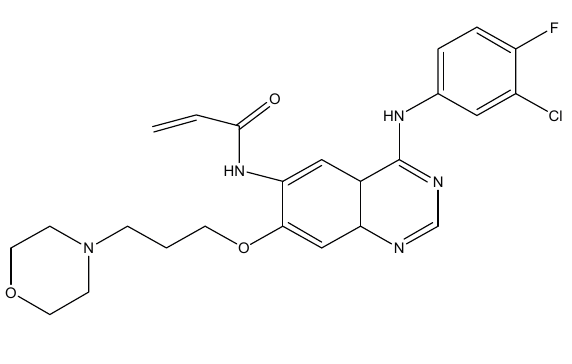
Figure 11. Structure of canertinib.